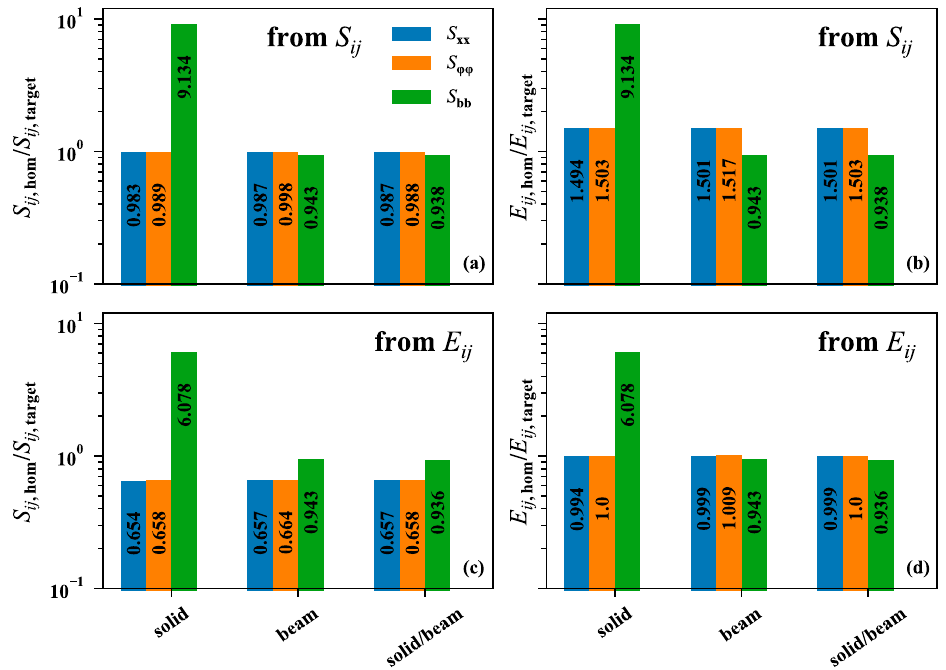
Figure 8. Components of S ij and E ij relative to their target values for varying cable-modeling approaches without anisotropic material behavior. The parameters of the models are calibrated to ( a , b ) fit S ij or ( c , d ) fit E ij .